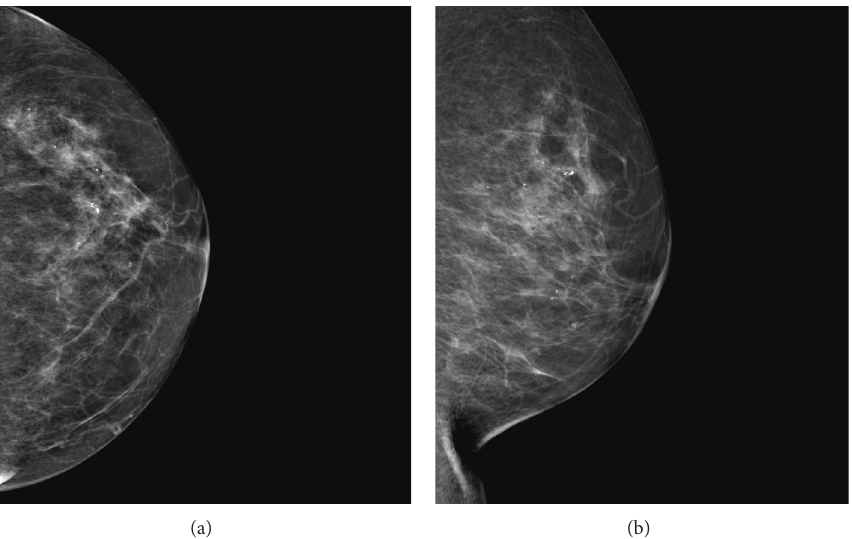
Figure1:Craniocaudal(CC)andmediolateraloblique(MLO)projectionsoftheleftbreastdemonstratesuspiciouspleomorphiccalcifications in a segmental distribution within the superior-medial quadrant, spanning approximately 2.3 cm. These calcifications were biopsy proven to represent amyloidosis and DCIS.